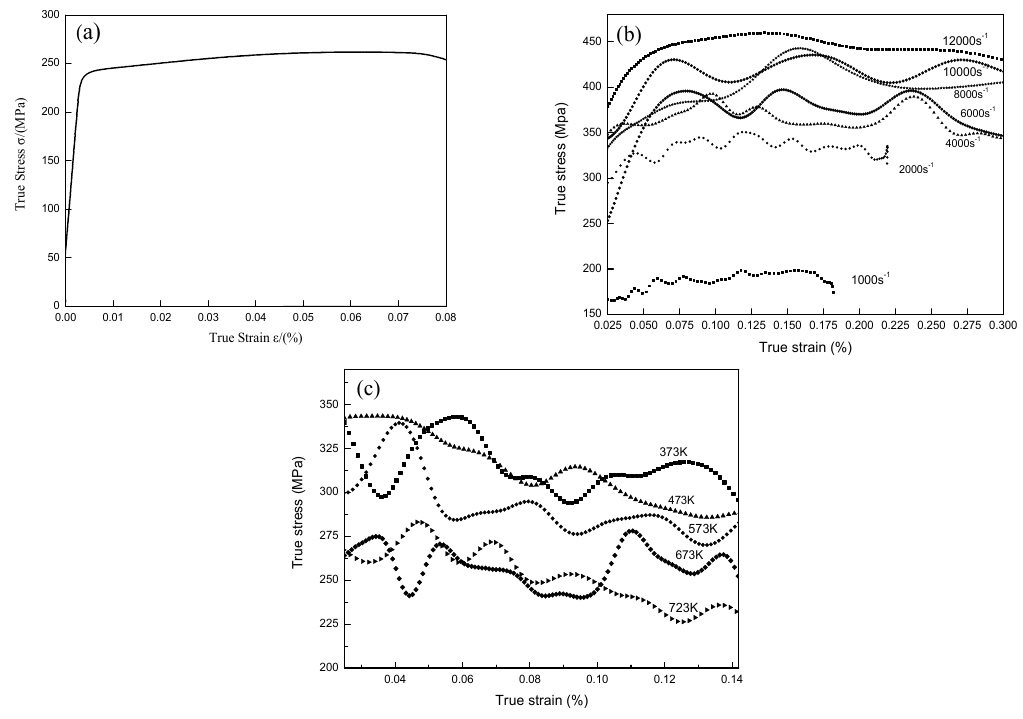
Figure 3. The true stress–strain curve of ADC12 aluminum alloy in the ( a ) quasi-static experiment; ( b ) different strain rates at 20 °C; and ( c ) different temperatures at 2000 s ‒ 1 .